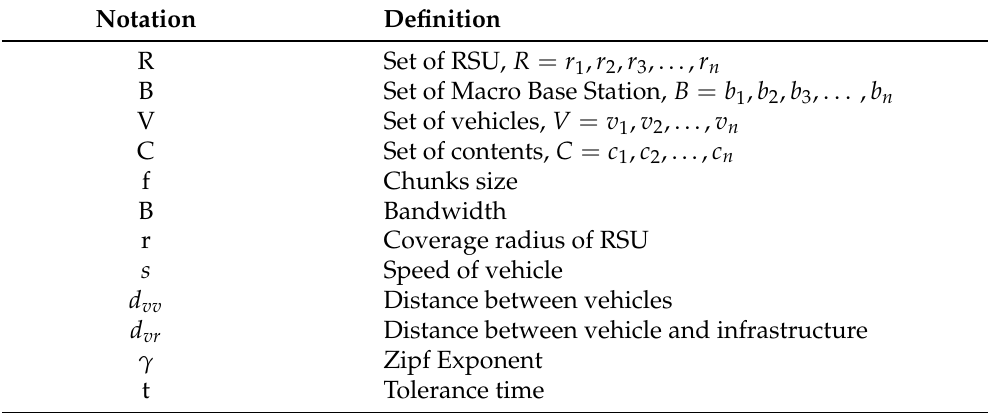
Table 2. Summary of key